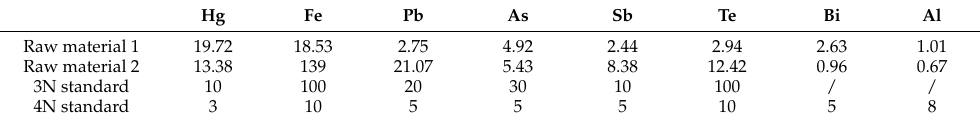
Table 1. Raw material compositions (units: ppm).